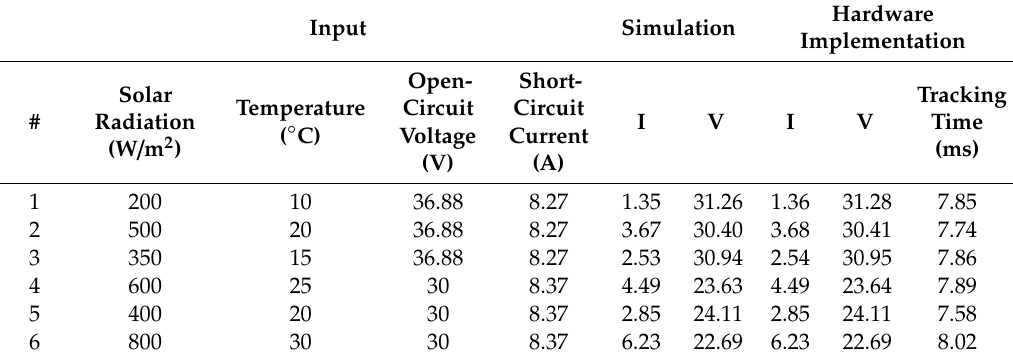
Table 6. Execution time and accuracy results from NARX network hardware